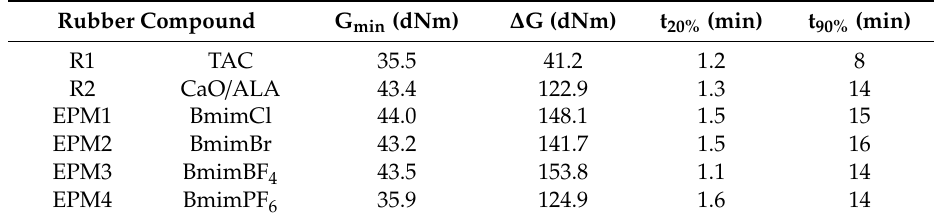
Table 6. Cure characteristics of silica-filled EPM compounds at 160 ◦ C (G min —minimum